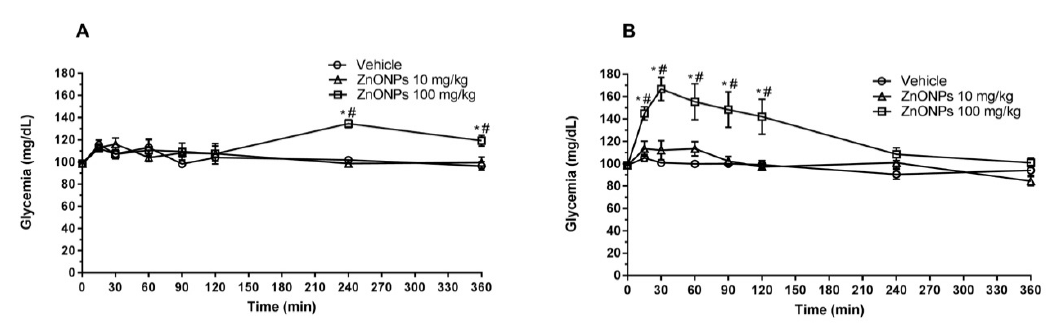
Figure 2. Short-term effects on glycemia of oral or intraperitoneal administration of ZnONPs in fasted healthy rats. ( A ) Oral administration (p.o). ( B ) Intraperitoneal route (i.p). Vehicle (Sterile 0.9% sodium chloride solution). * significant in comparison with vehicle ( p < 0.05, n = 8 by group), # significant difference in comparison with group treated (10 mg/kg).